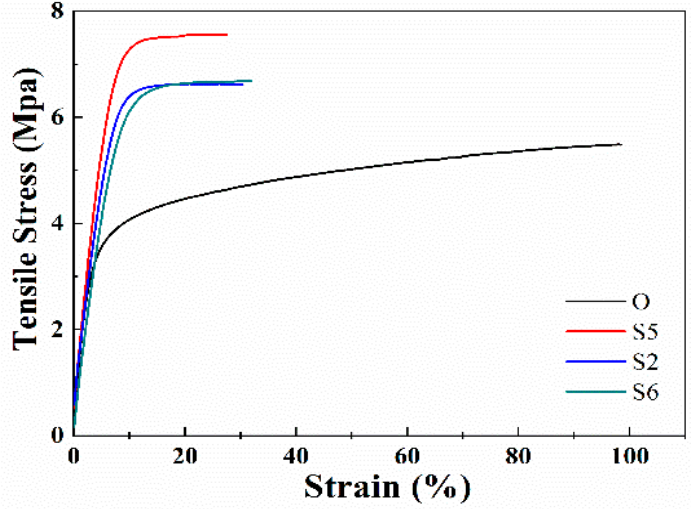
Figure 9. The stress-strain curves of the membrane samples stretched with different stretching rates.